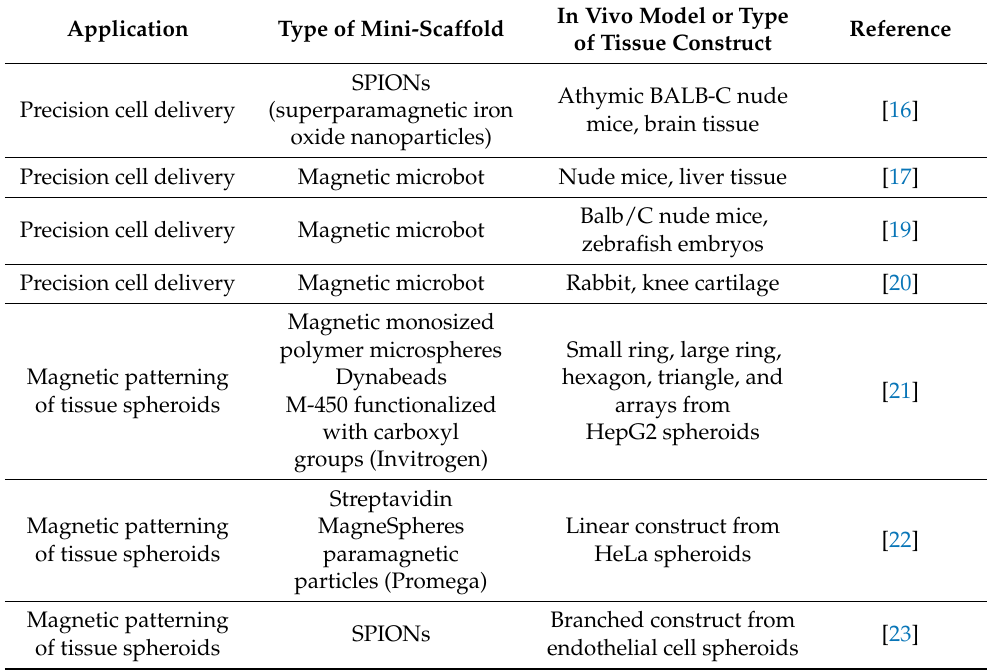
Table 1. Biomedical applications of